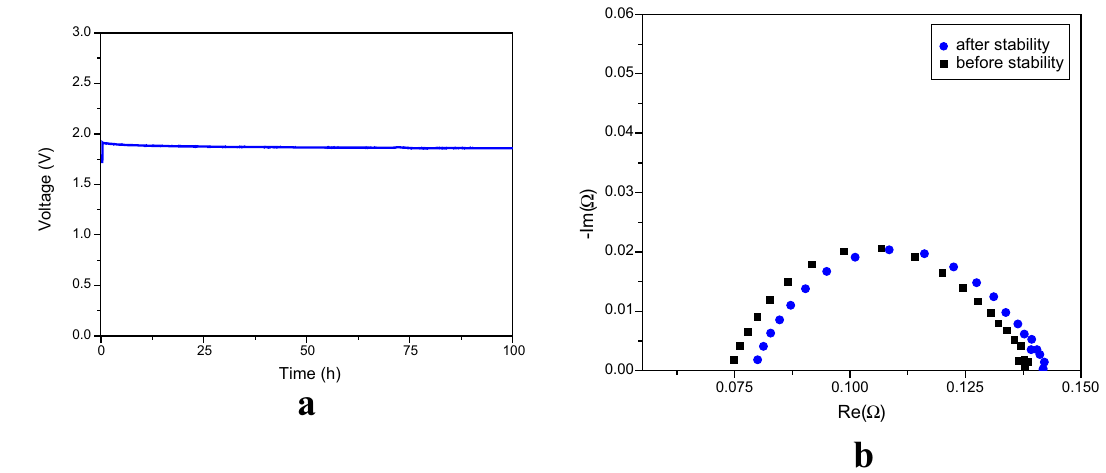
Figure 11. (a) Stability evaluation of the MEA over 100 h at 500 mA cm –2 , at 60 °C. ( b) Stability determination from the Nyquist plots of the EIS measurements (from 100 kHz to 1 MHz) before and after 100